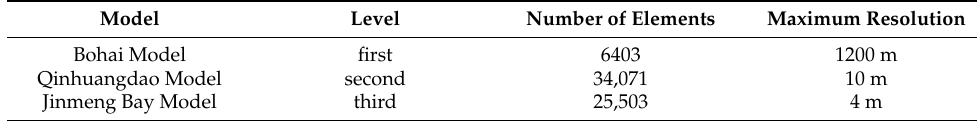
Figure 4. The bathymetries of ( a ) the initial construction conditions, ( b ) the first-stage construction conditions, ( c ) the current construction conditions.